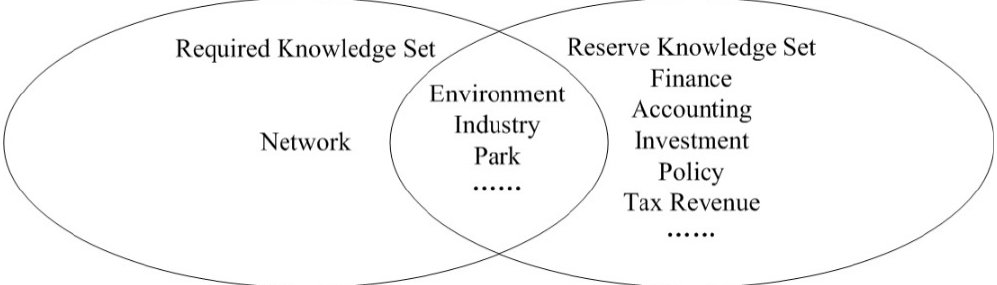
Figure 3. The knowledge gap obtained by Venn diagram analysis.